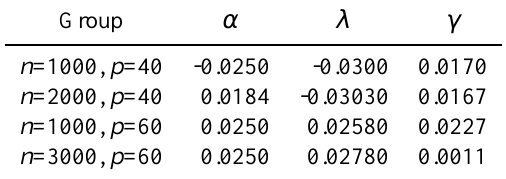
Table 4. Step size along the path of steepest descent.